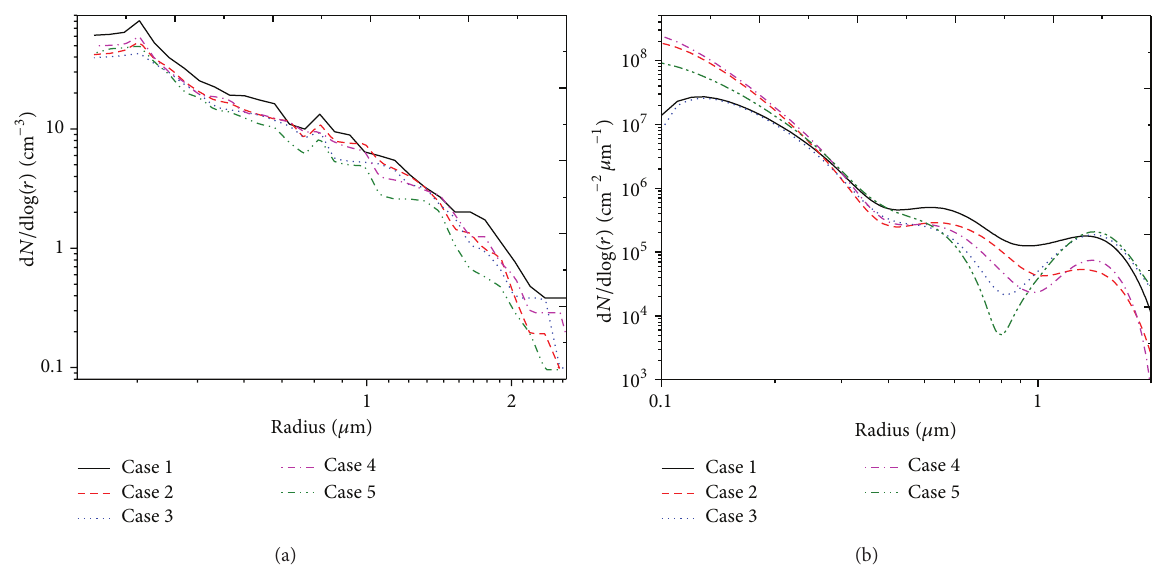
Figure 8: Some particle number size distributions obtained synchronously by sun photometer and APS-3321, respectively, during the observation